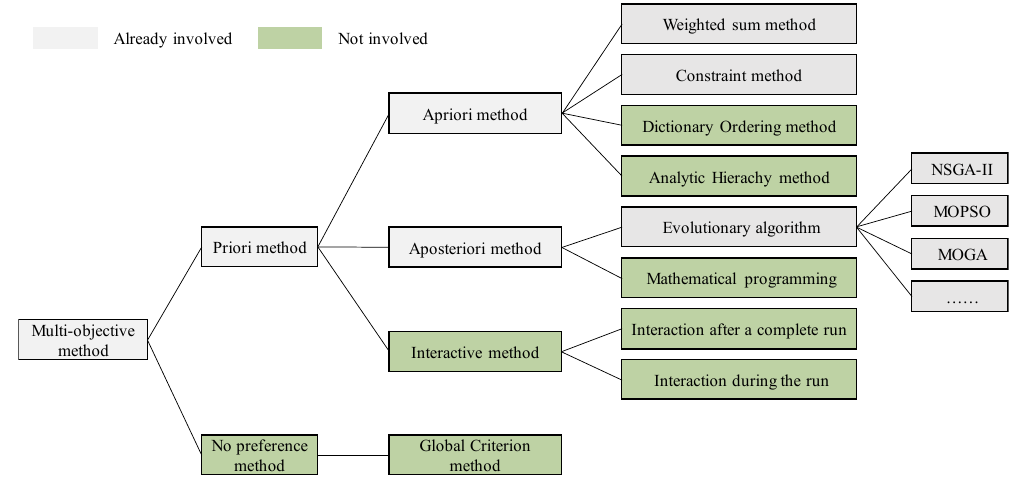
Figure 5. Multi-objective optimization methods.